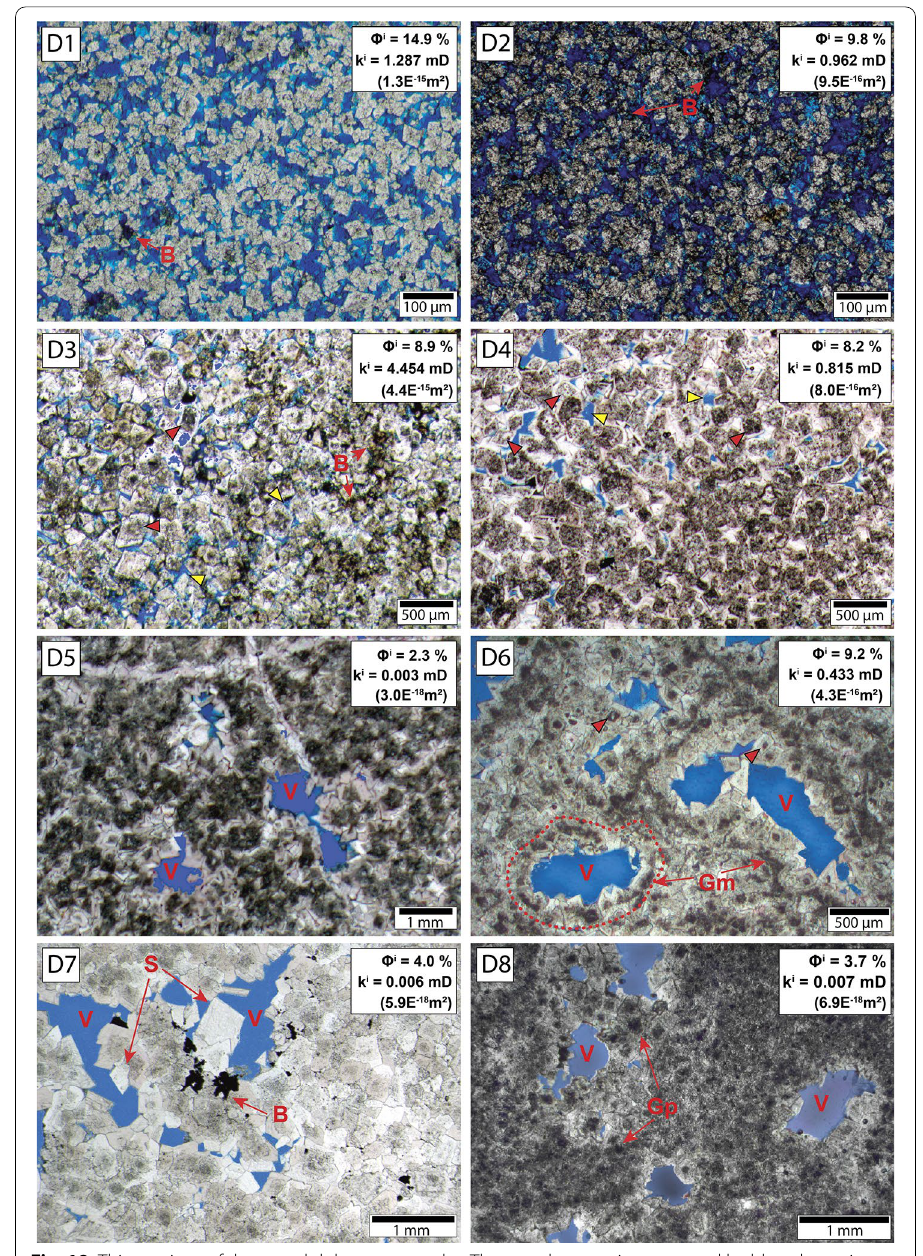
Fig. 18 Thin sections of the tested dolostone samples. The samples were impregnated by blue-dye resin to visualize the pore space and partially stained with Alizarin-S for identification of calcite. See text for a detailed description of the thin sections and the classification of